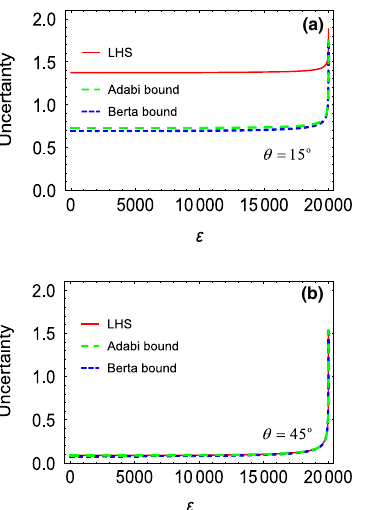
Fig. 2 The LHS, Adabi bound, and Berta bound with respect to the volume expansion ε when considering two complementary observables (σ ,σ ) . σ = 2, (cid:14) = 2, μ x y